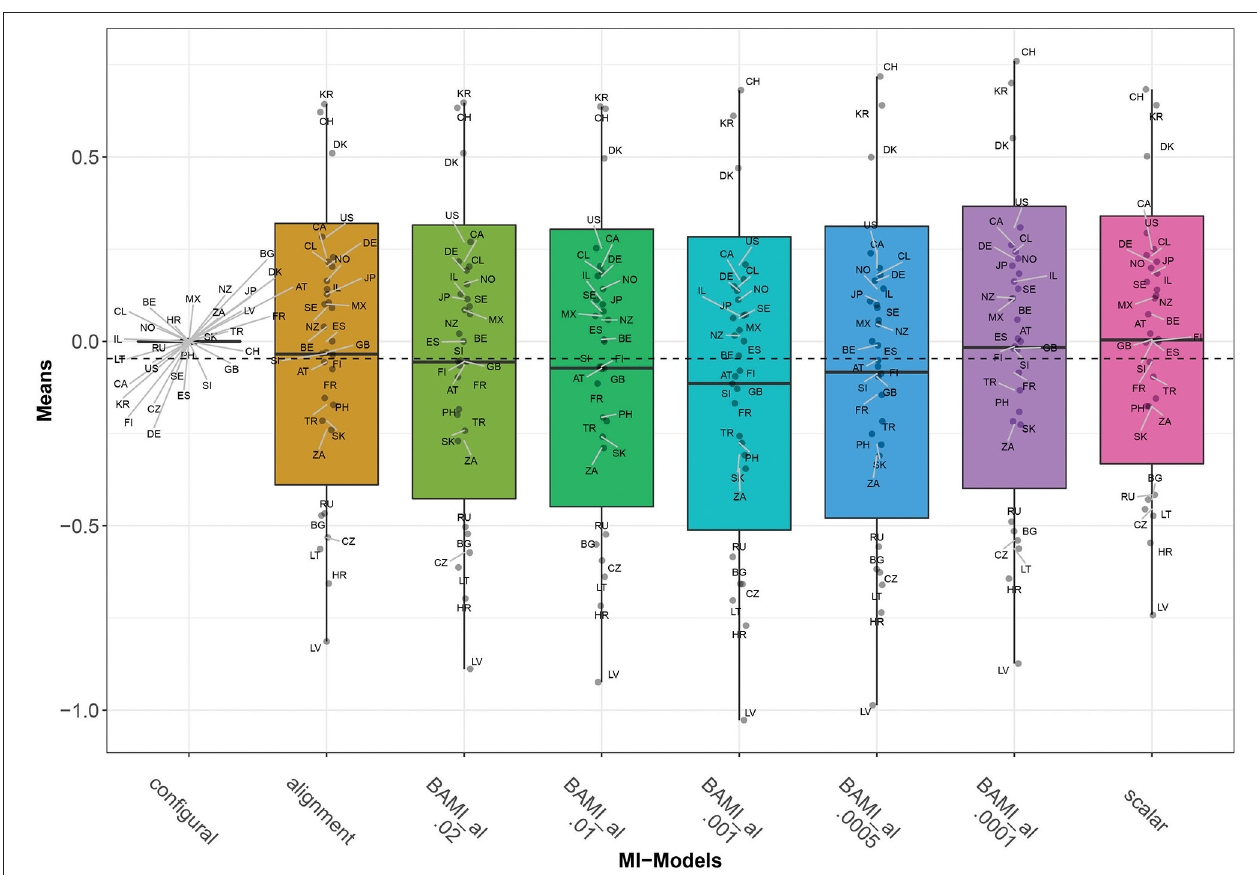
FIGURE 3 | Means for configural invariance, scalar invariance, ML alignment, and BAMI models with alignment. AT, Austria; BE, Belgium; BG, Bulgaria; CA, Canada; CL, Chile; HR, Croatia; CZ, Czech Republic; DK, Denmark; FI, Finland; FR, France; DE, Germany; GB, Great Britain; IL, Israel; JP, Japan; LV, Latvia; LT, Lithuania; MX, Mexico; NZ, New Zealand; NO, Norway; PH, Philippines; RU, Russia; SK, Slovakia; SI, Slovenia; ZA, South Africa; KR, South Korea; ES, Spain; SE, Sweden; CH, Switzerland; TR, Turkey; US, United States. The x-axis shows the different models—configural, scalar, ML alignment, and BAMI with alignment—with their specific variances. The dashed black line shows the overall